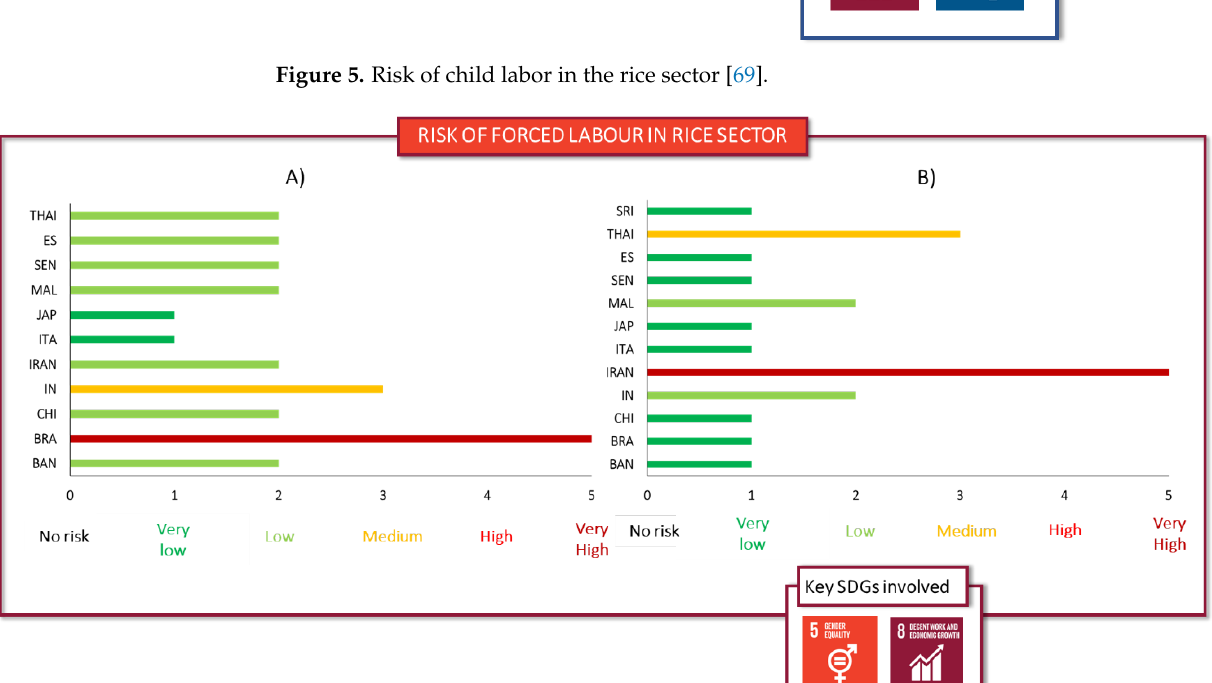
Figure 6. Risk of forced labor in rice production in that country [70,71]. ( A ) expressed according to goods produced by forced labor (Number of goods in the sector). ( B ) expressed according to fre- quency of forced labor (Cases per 1000 inhabitants in the country)